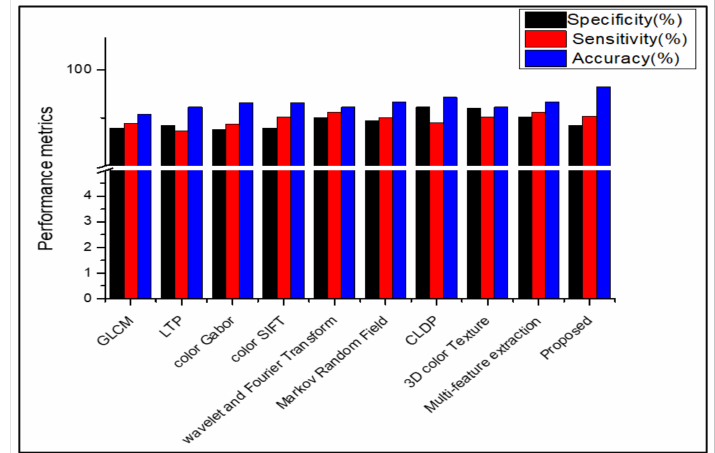
Figure 9. Comparison of performance using various feature descriptors in